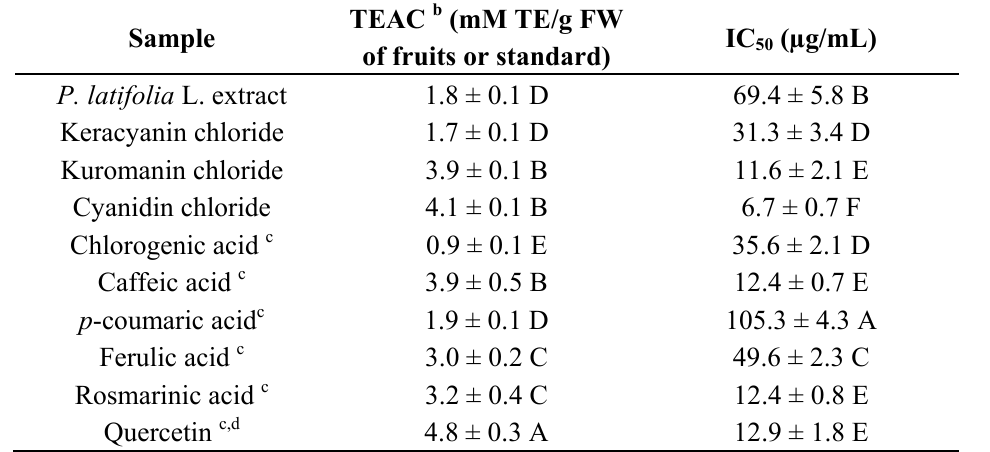
Table 2. Radical scavenging capacities of a methanolic extract from Phillyrea latifolia L. fruits and its anthocyanin and phenolic acid components, expressed as TEAC and IC